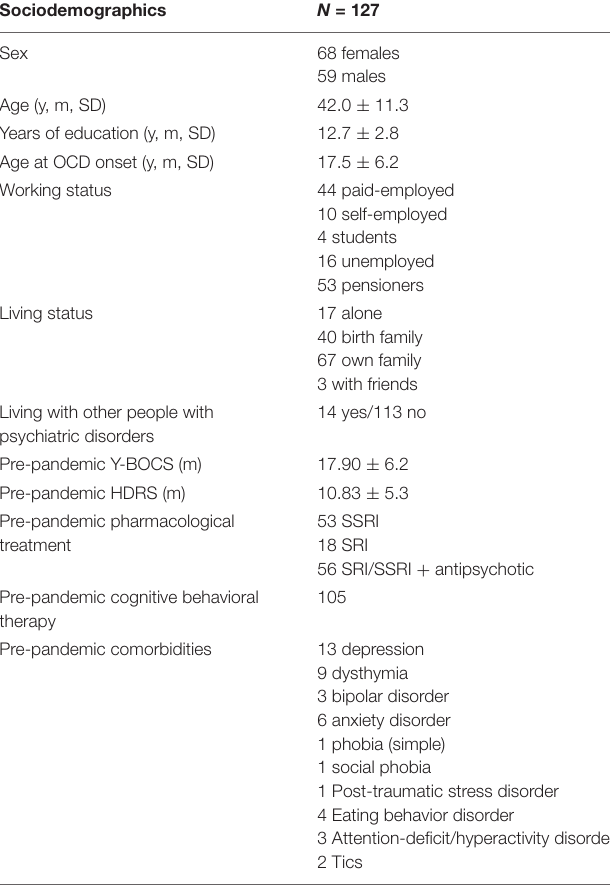
TABLE 1 | Sociodemographic data of the sample.